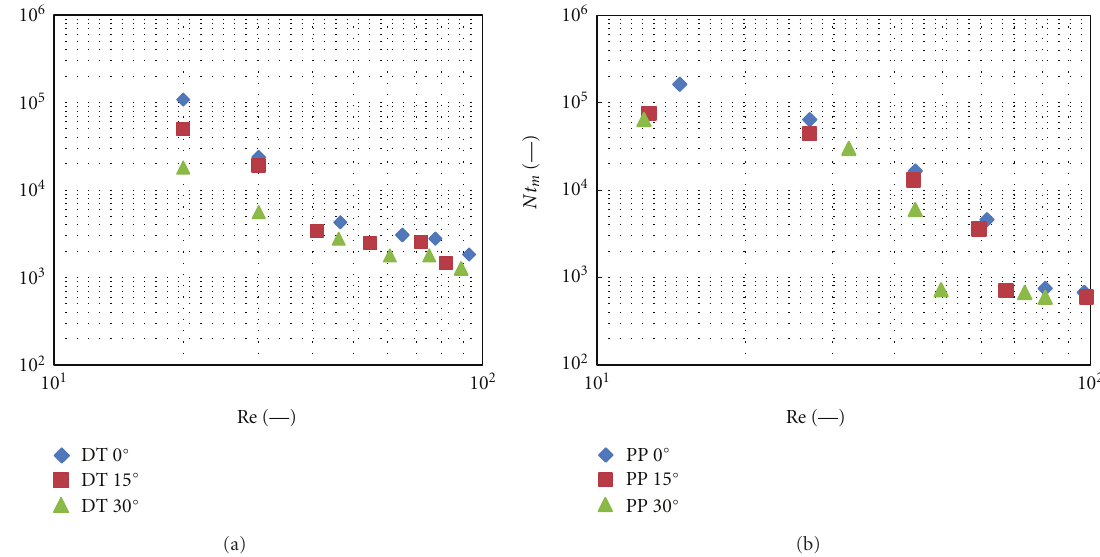
Figure 3: Relationship between dimensionless mixing time and Re number for disk turbine and pitched paddle.